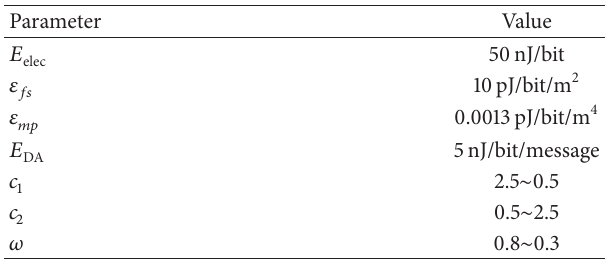
Table 1: Simulation parameters for DCH-NPSO.